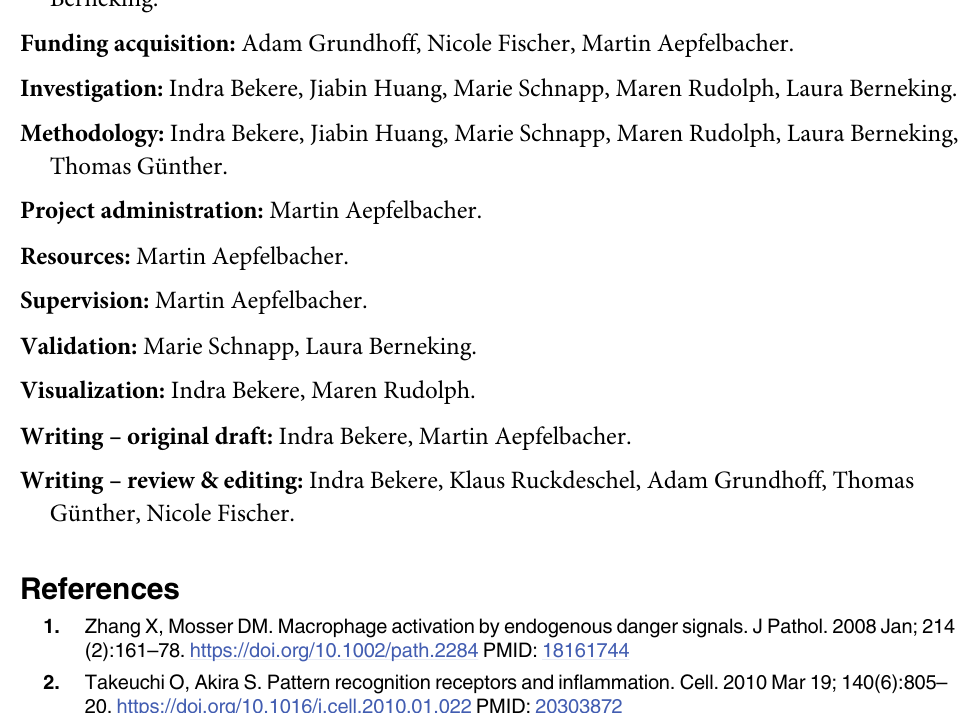
S15 Table. Primer sequences used for ChIP-qPCR and RT-qPCR analysis. S16 Table. Enriched pathways associated with trafficking, MAPK signaling, Akt signaling and cell death. S17 Table. Summary of all replicates used for ChIP-seq and RNA-seq experiments. S18 Table. All filtered differentially enriched regions for histone marks based on diffReps